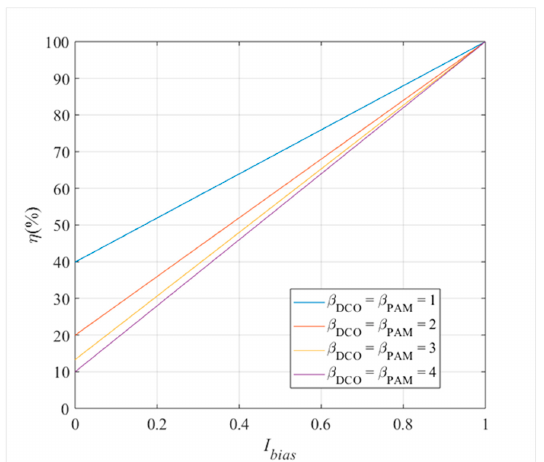
Figure 3. Dimming level, η , versus bias, I Bias , values in dc-biased pulse amplitude modulated orthogonal frequency division multiplexing (DPO-OFDM), where 𝛽 terms represent scaling factors.